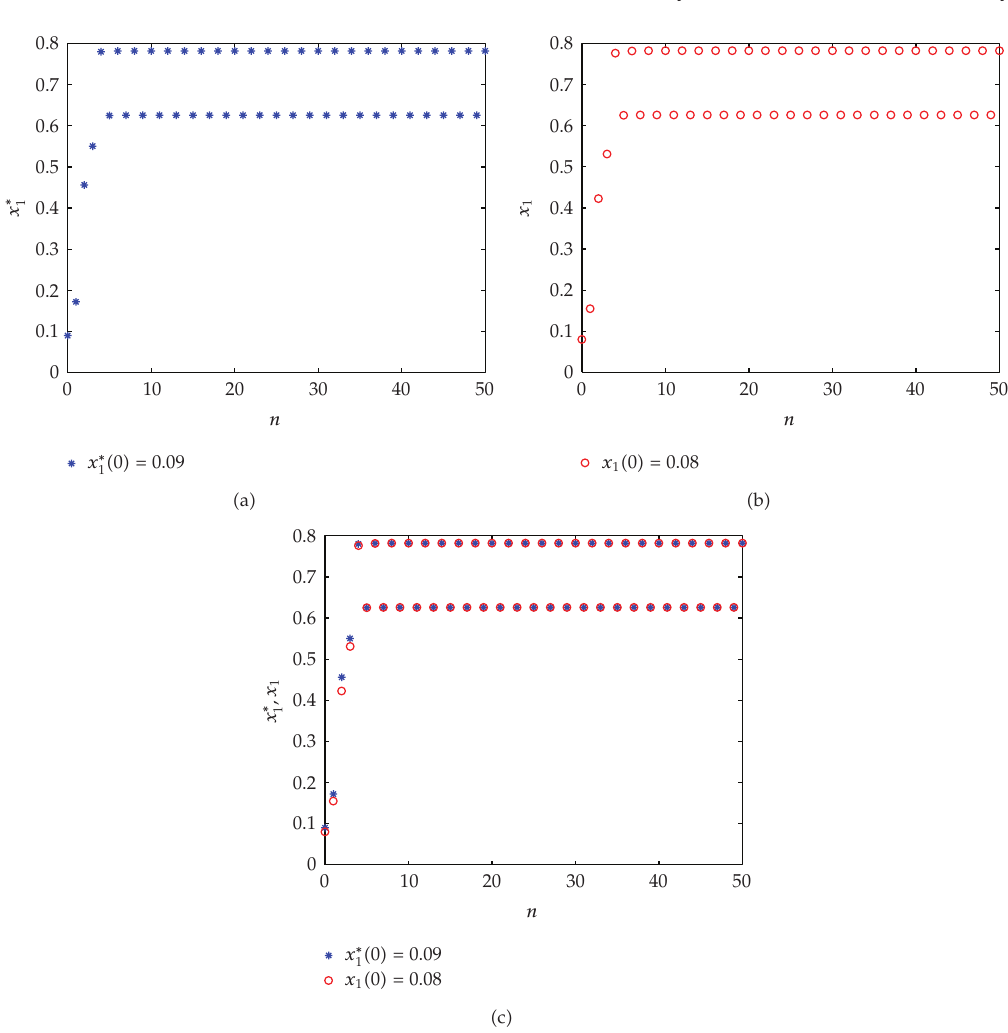
(cid:6) 0 (cid:7) (cid:8) 0 . 09 for n ∈ (cid:2) 0 , 50 (cid:3) . (cid:6) b (cid:7) Time series of x with x ∗ 1 1 and x 1 for n ∈ (cid:2) 0 , 50 (cid:3) in the same coordinate system. 1